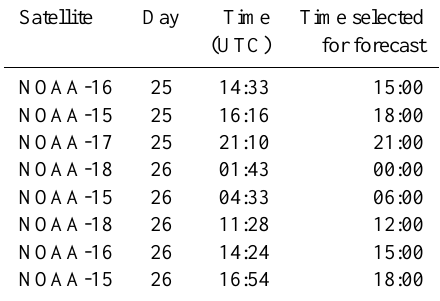
Table 1. Overpasses in September 2006 for the medicane.